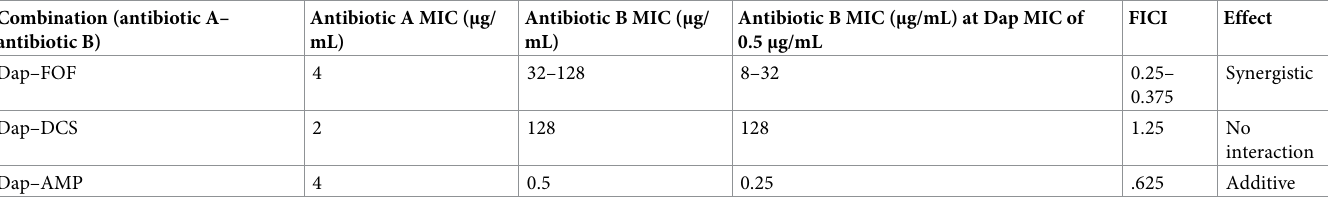
Represented are the ranges of individual antibiotic MICs along with the range of the MICs of antibiotic B combined with daptomycin at 0.5 μ g/mL. n = 3 for each experiment. FICI � 0.5: Synergistic, FICI = 0.5–1: Additive; FICI = 1–4: No interaction. DAP; daptomycin, FOF; Fosfomycin, DCS; D-cycloserine, AMP;